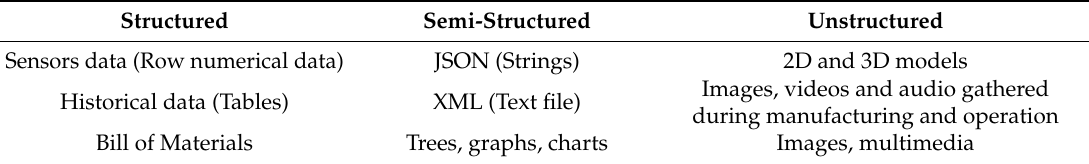
Table 2. Types of digital twin data collected at aggregation